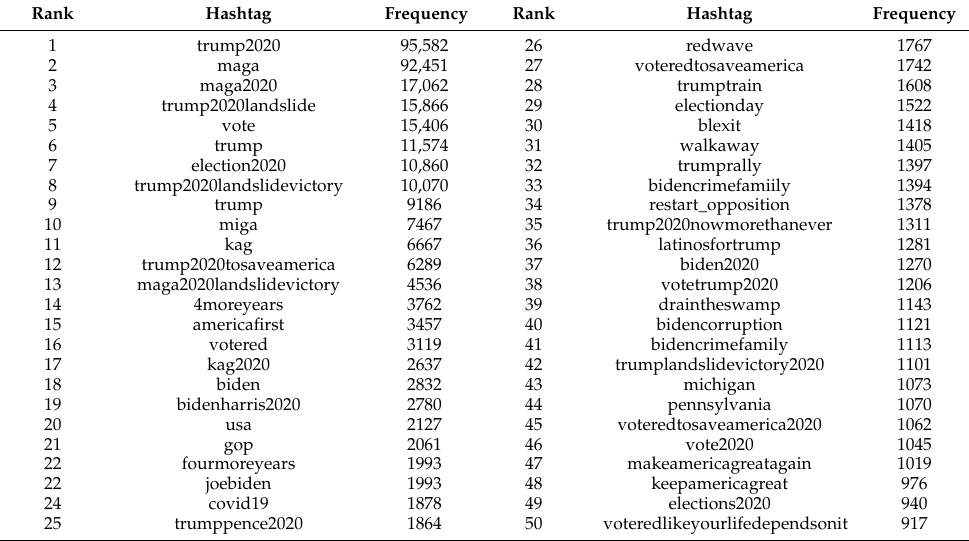
Table 4. The 50 most used